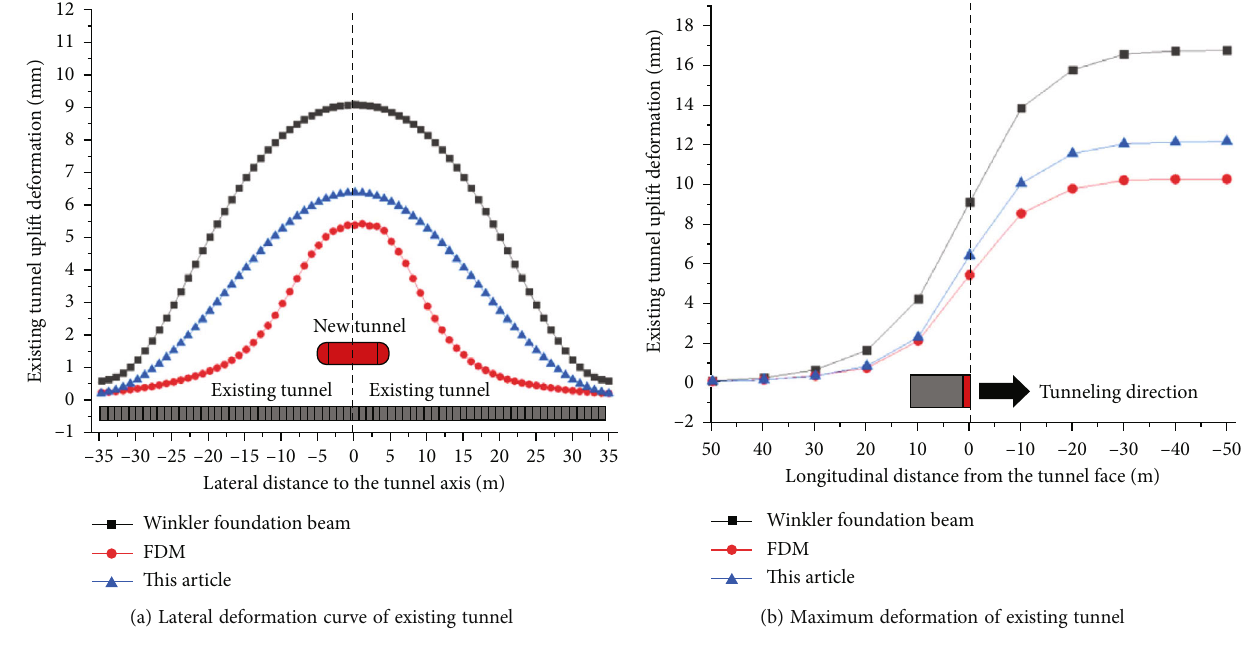
Figure 15: Comparison of existing shield tunnel deformation calculation.